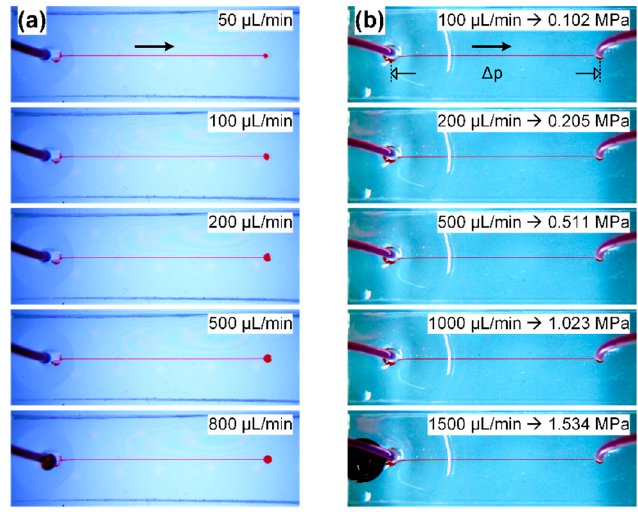
Figure 6. Liquid leakage test for the bonded PDMS-SU-8 channels. ( a ) Single-ended channel infused with a red dye solution. The flow rate was increased from 50 µL/min to 800 µL/min, at which point the red dye leaked out of the inlet; ( b ) double-ended channel infused with a red dye solution. The flow rate was increased up to 1500 µL/min when the red dye leaked out of the inlet. The hydraulic pressure from the channel inlet to the outlet, Δ p , was calculated by using Hagen-Poiseuille’s equation, according to the corresponding flow rate and the geometric parameters of the channel.